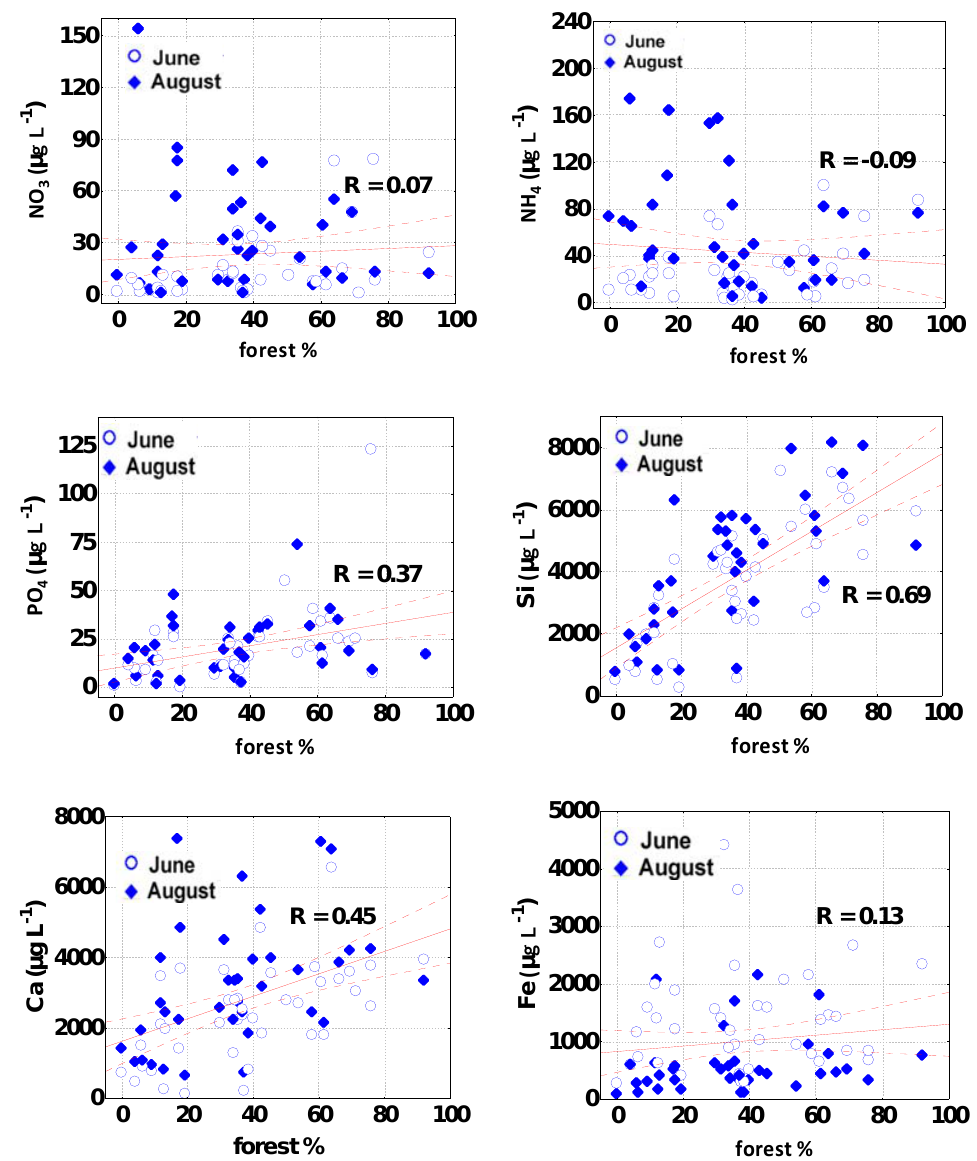
Figure 5. N ‐ NO 3 , N ‐ NH 4 , P ‐ PO 4 , Si, Ca, and Fe relationships with forest proportion on the watershed during June (open circles) and August (closed diamonds) in all rivers of the WSL sampled in this work. The R value is the Pearson correlation coefficient for the full dataset. The solid line is for the main trend and the dashed lines are significant at p < 0.05 .